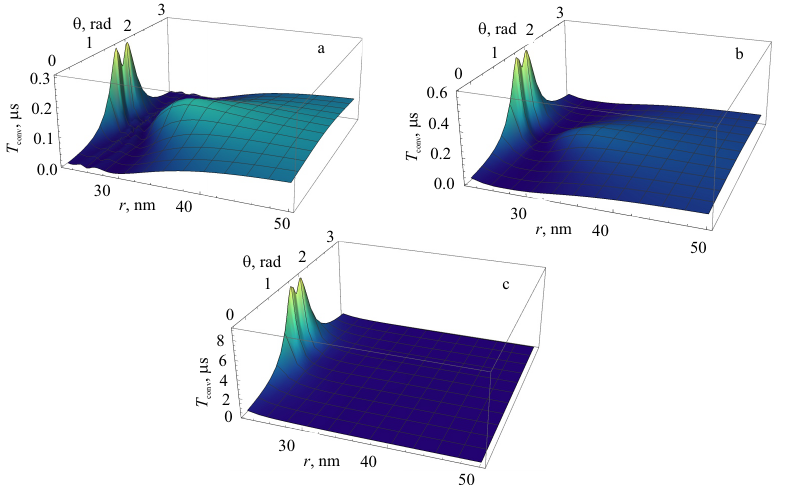
Figure 10. Dependences of the convergence time T conv on coordinates of a QE r (left) and θ (right) around an NP and on the normalized frequency detuning D = 0 ( a ), D = 1 ( b ) and D = 5 ( c ) at ∆ ω = 1 L